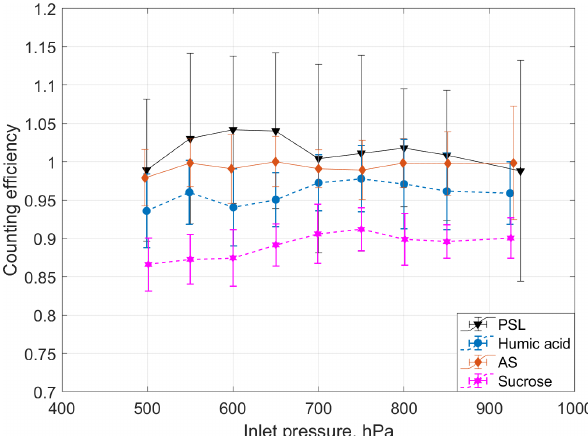
Figure 8. The vWCPC 3789 counting efficiency at different oper- ating pressure with four different types of 100nm aerosol particles (PSL, humic acid, AS, and sucrose) when the temperature condi- tions are T cond = 27 ◦ and T ini = 59 ◦